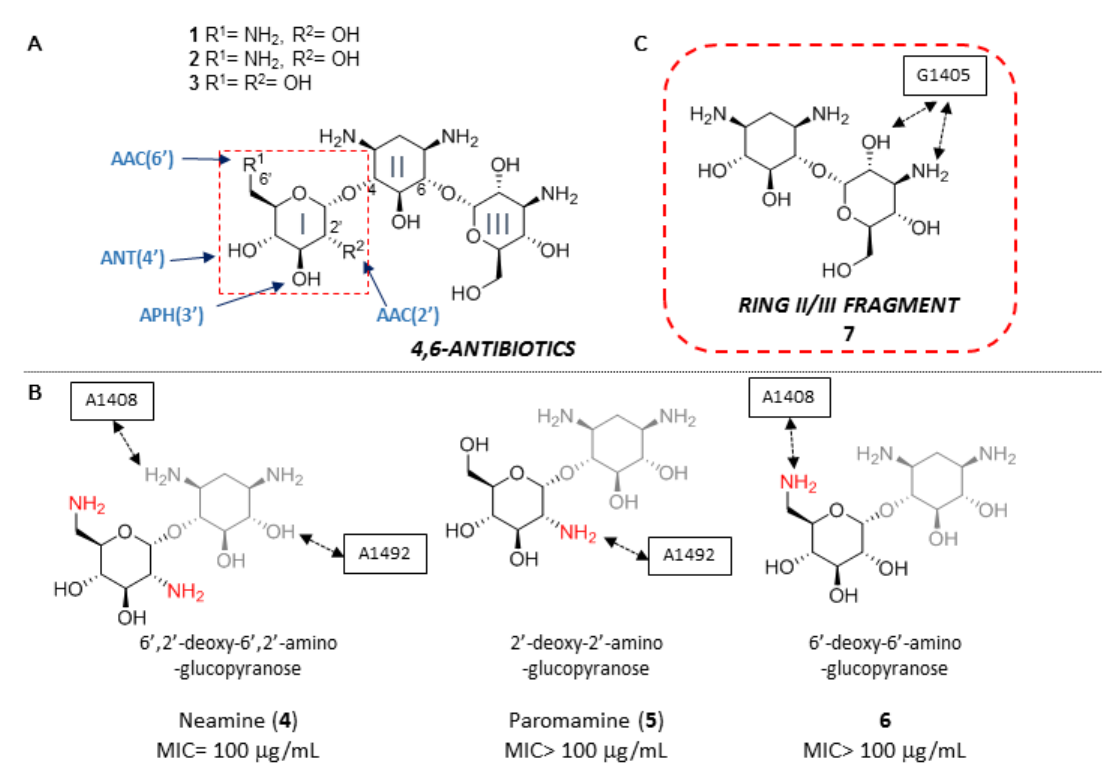
Figure 1. ( A ) Structure of kanamycin A ( 1 ), kanamycin B ( 2 ) and kanamycin C ( 3 ). ( B ) Ring I / II fragments ( 4 – 6 ) of kanamycins. The functional relevance of the drug / RNA contacts established through ring I amines are indicated in each case. Besides, typical ranges for the MIC values of natural kanamycins ( 1 – 3 ) and of the fragments thereof ( 4 – 6 ) are also presented. ( C ) Ring II / III fragment studied in this paper ( 7 ).